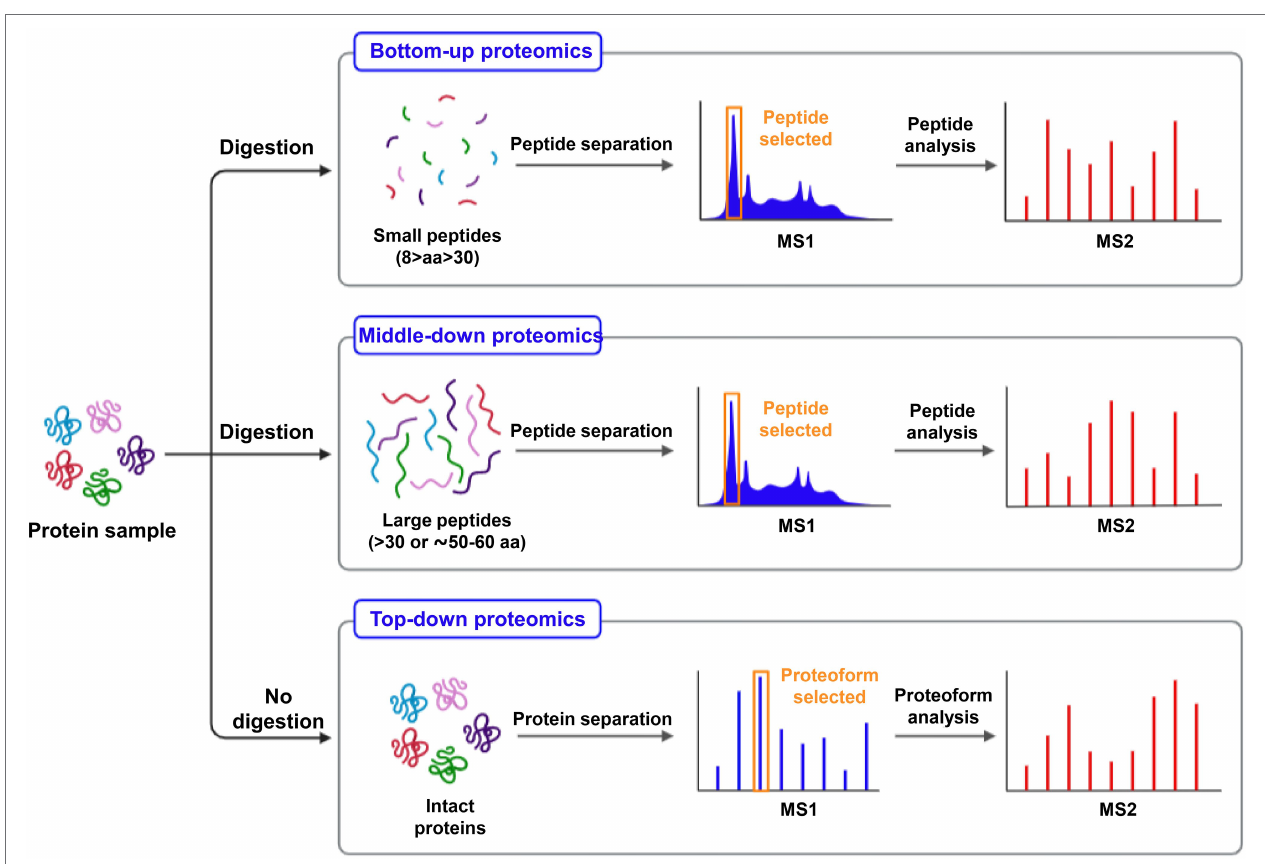
FIGURE 2 | A proposed workflow for protein digestion and MS analysis for the investigation of large (intact proteins), medium (peptides >30 aa), and small size (8–30 aa) protein